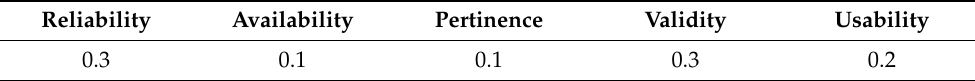
Table 10 Table 10. Aspect